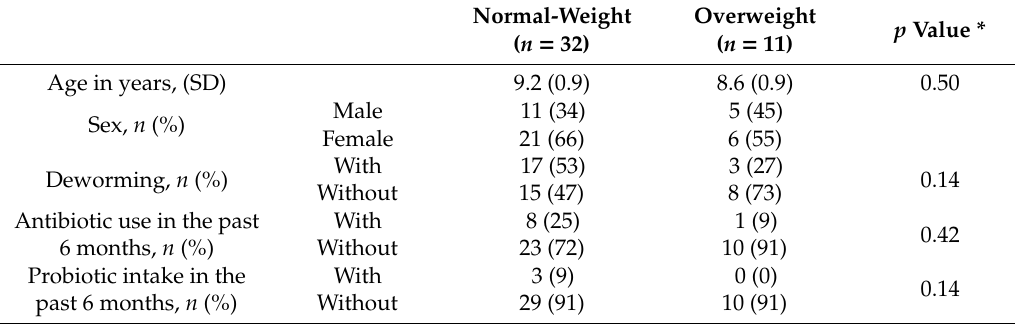
Table 1. Characteristics of study